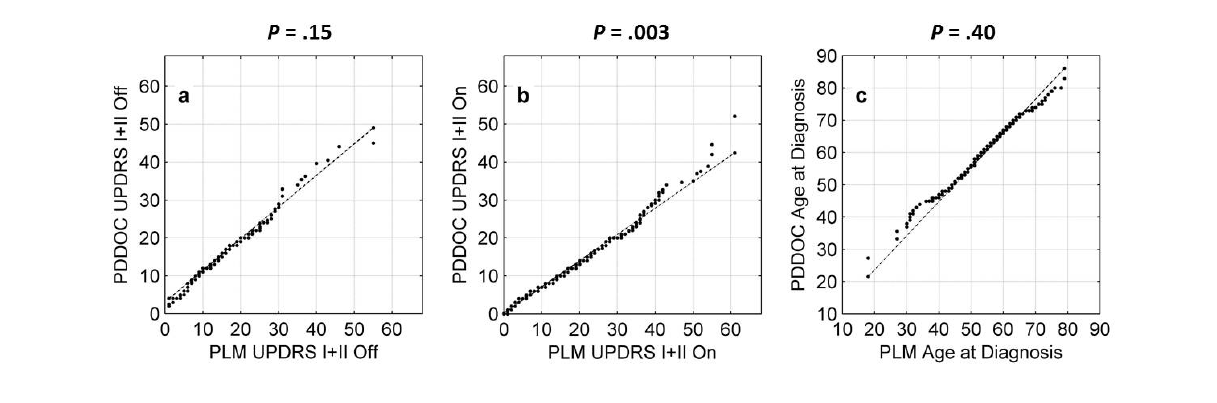
Figure 1. Validating the online self-reported PatientsLikeMe (PLM) dataset against the clinically scored Parkinson’s Disease Data and Organizing Center (PD-DOC) reference dataset. Visual comparisons using quantile-quantile plots; statistical comparisons using the 2-sample Kolmogorov-Smirnov (K-S) test applied to z-scored data (K-S test results displayed as the P values above graphs). (a) Unified Parkinson’s Disease Rating Scale (UPDRS) values (sum of Parts I and II) for values labeled as “off” treatment in the PLM dataset against values labeled as “off state” in the PD-DOC data; (b) as with (a), except for the “on” treatment/state labels; (c) ages at